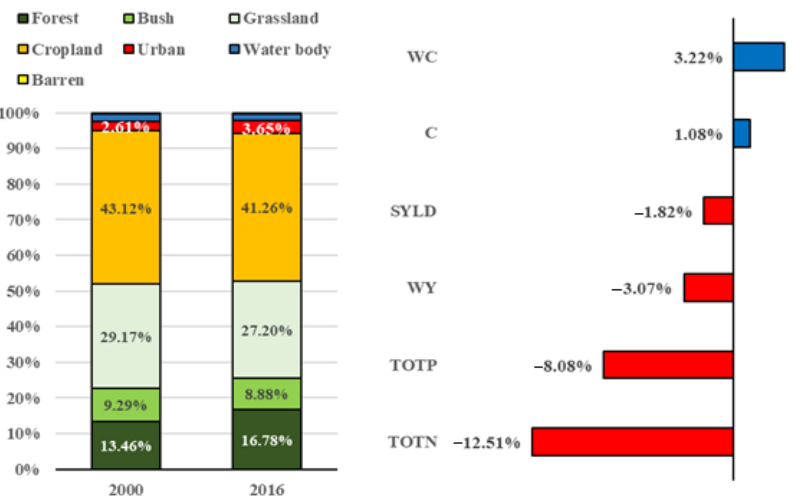
Figure 8. Land-use change from 2000 to 2016. The left panel shows the percentages of different land-use classes in 2000 and 2016. The right graph shows the change rate of different ESs.